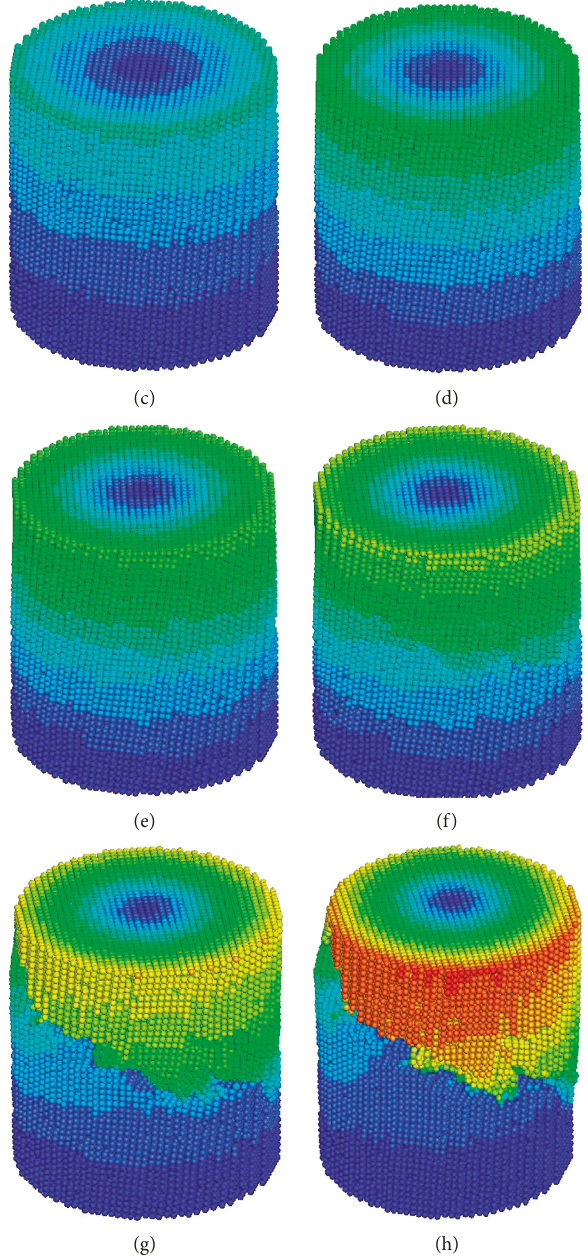
Figure 19: Displacement cloud images of two numerical models. (a) Initial stage. (b) Earlier stage of the loading period. (c) Loading period 1. (d) Loading period 2. (e) Loading period 3. (f) Crack appeared. (g) Crack propagation. (h) End of